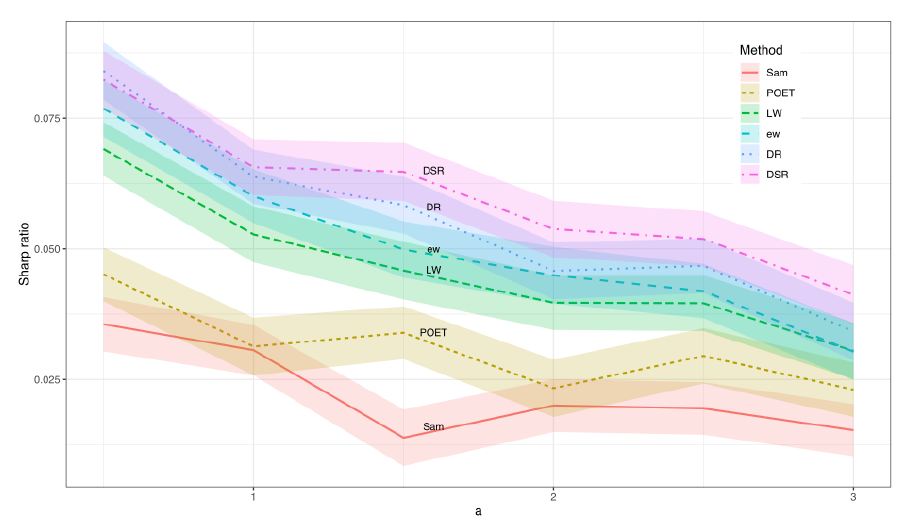
Figure 2. Sharpe ratio of various MVPs under noisy